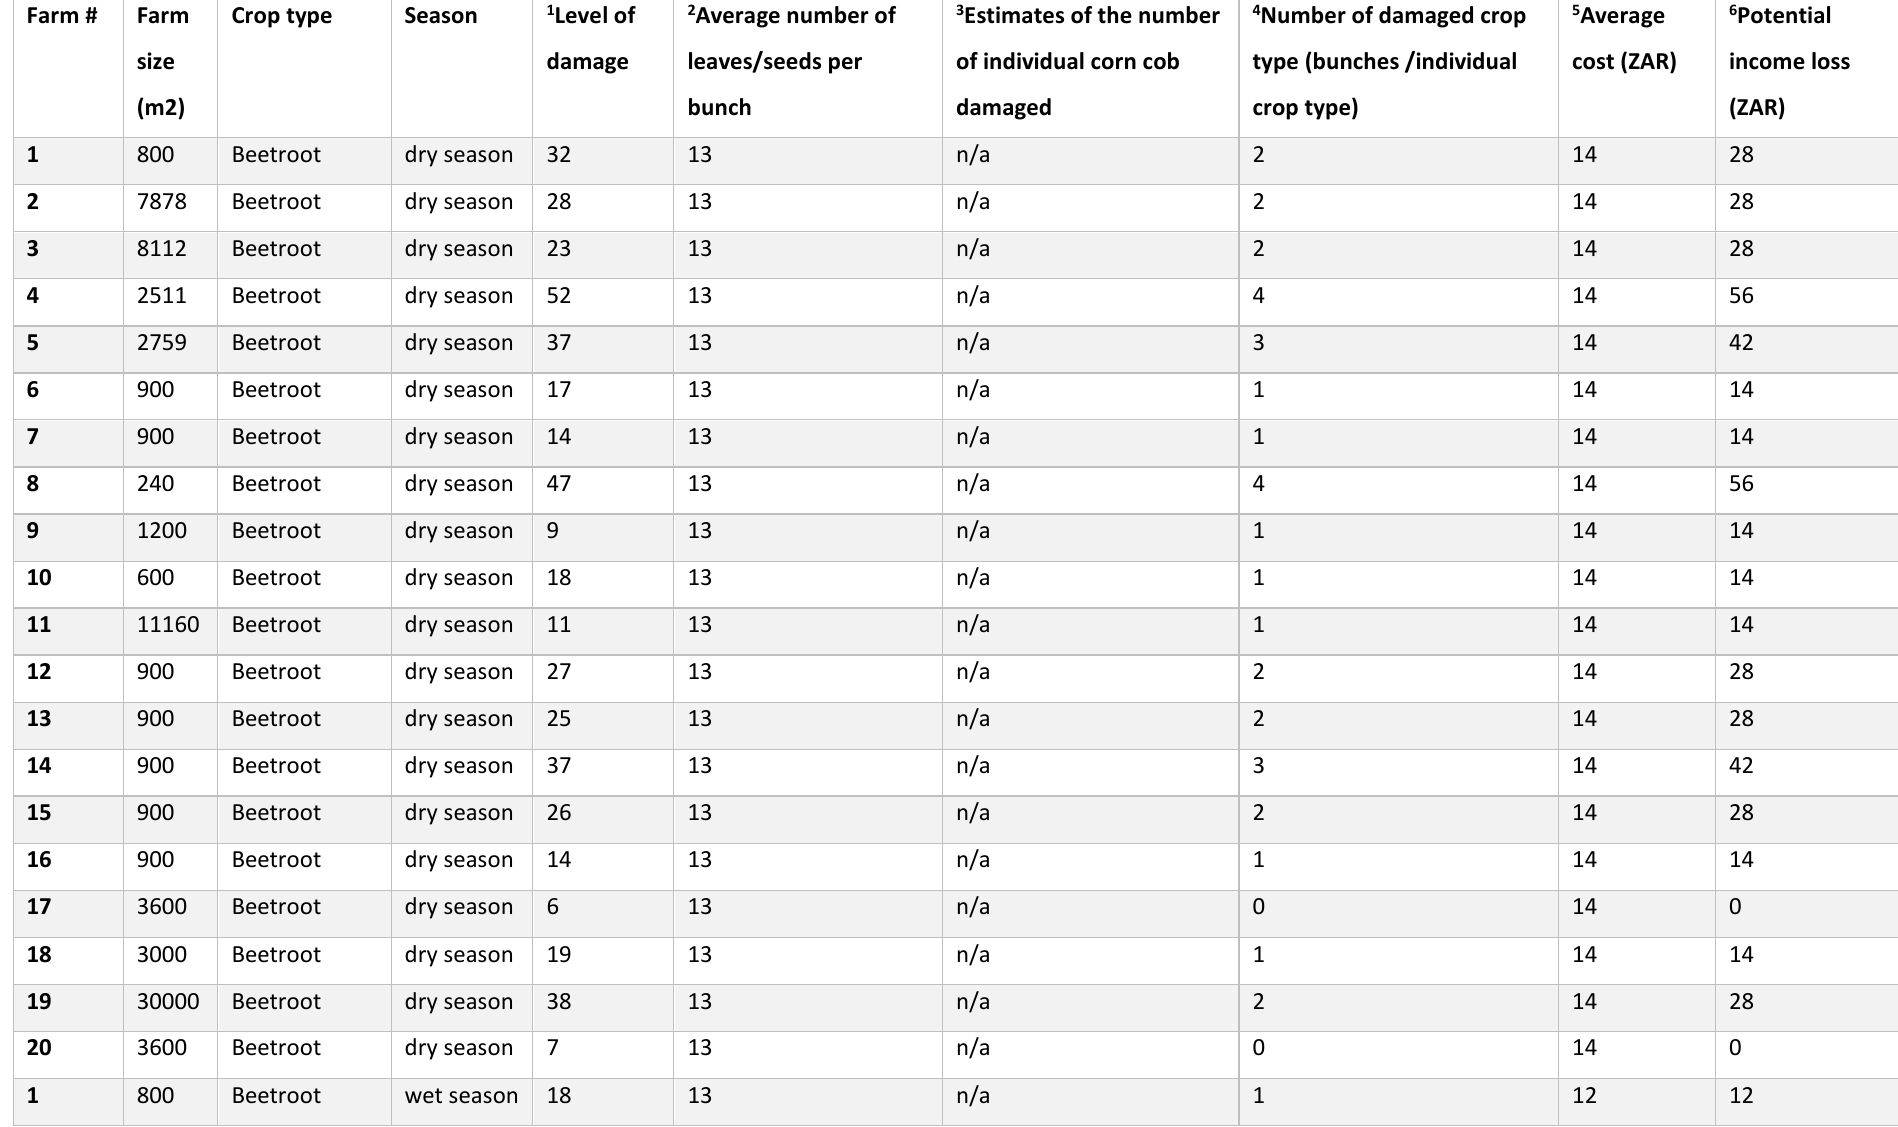
TABLE 1-A1: Potential income loss index for beetroot, common bean, maize and spinach due to crop raiding during the dry and wet season. The potential income loss is calculated as the number of damaged food crop types multiplied by the average costs